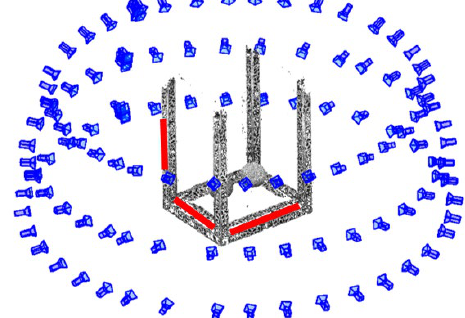
Figure 3. Test configuration and scale bars (red)